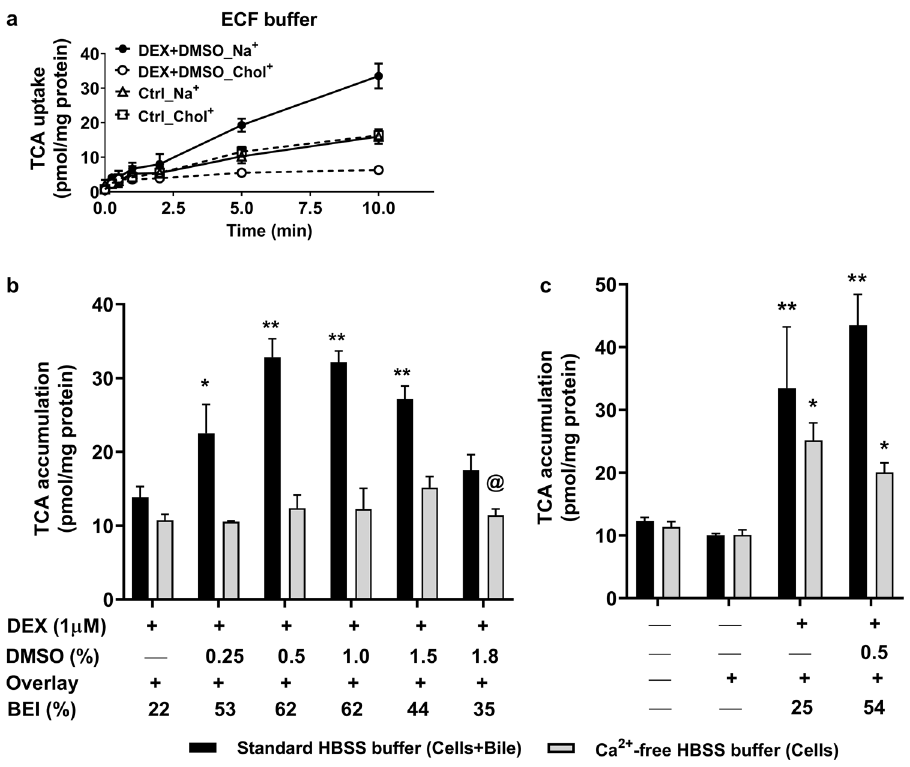
Figure 6. Effect of dexamethasone (DEX) and DMSO on bile acid uptake and biliary excretion index (BEI) in differentiated HuH-7 cells. ( a ) Uptake of 4 µM taurocholic acid ([ 3 H]-TCA; 400 nCi/mL) was measured in control (Ctrl) and differentiated (1 µM DEX + 0.5% DMSO) HuH-7 cells without overlay using extracellular fluid (ECF; N = 2, in triplicate) buffer over 10 min. ( b ) Accumulation and BEI of 2 µM [ 3 H]-TCA (200 nCi/ mL) were measured in HuH-7 cells with overlay in standard or Ca 2+ -free Hanks balanced salt solution buffer (HBSS) at various DMSO concentrations, and ( c ) in the presence and absence of DEX, overlay and 0.5% DMSO. Data were plotted as mean ± standard deviation ( n = 3) and BEI was calculated using Eq. (1). Statistically significant differences were measured using an ordinary two-way ANOVA with Dunnett’s multiple comparisons test [*, p < 0.05, **, p < 0.0001, ( b ) cells cultured with overlay and with DMSO vs. without DMSO; ( c ) control cells cultured without vs with overlay and cells cultured with overlay with DEX ± DMSO]. @ Cell detachment observed.